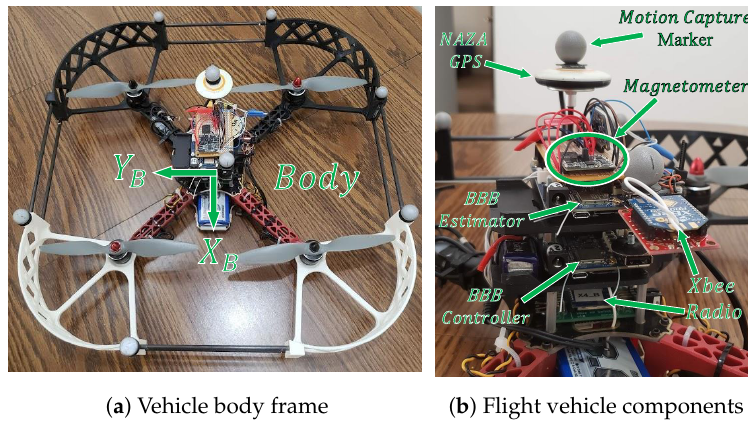
Figure 2. Flight vehicle.